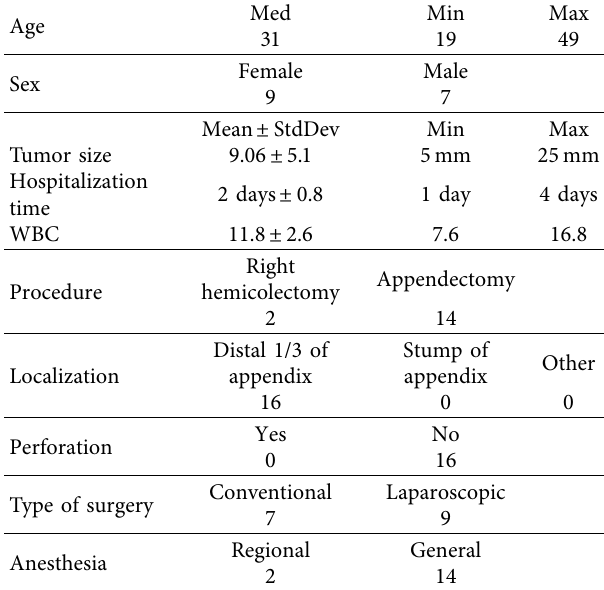
Table 1: Demographic and clinical data of the patients ( n :